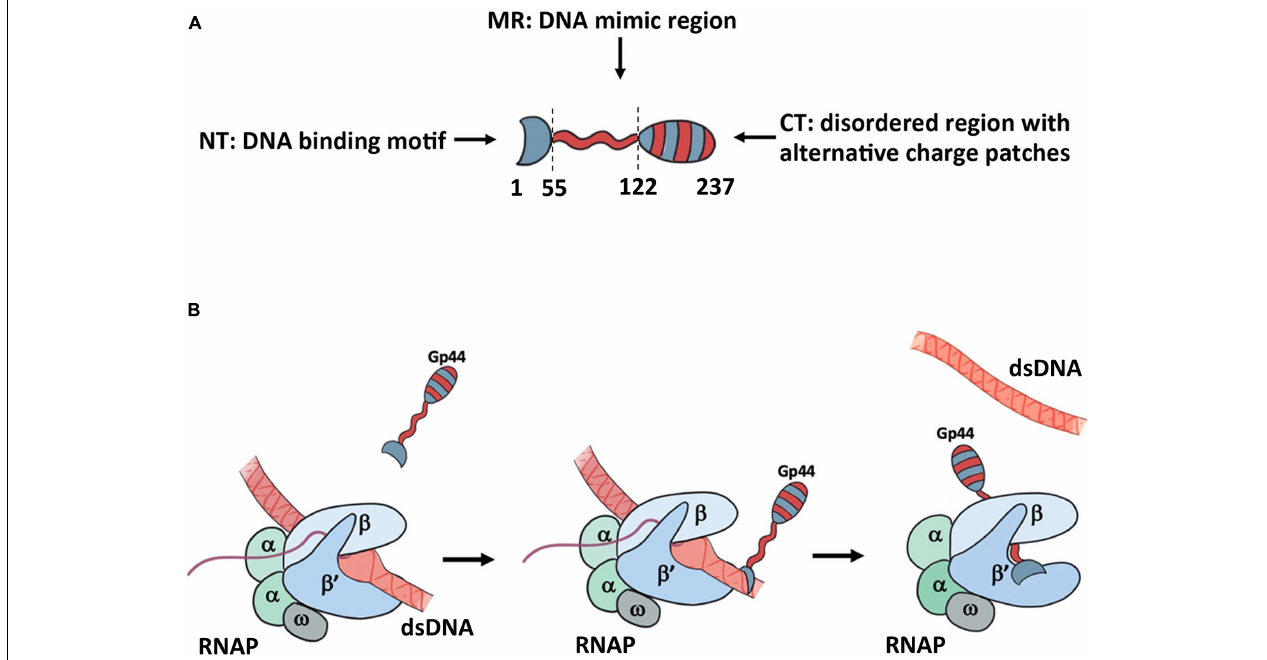
FIGURE 5 | Proposed model for the mechanism of action for Gp44. (A) the domain arrangement of Gp44 in cartoon. Red stands for negatively charged and blue stands for positively charged patch. (B) Proposed model for Gp44/DNA/RNAP interaction. While the exact mechanism of how Gp44 replaces DNA remains unclear, it could explain previous observations, including causing premature of